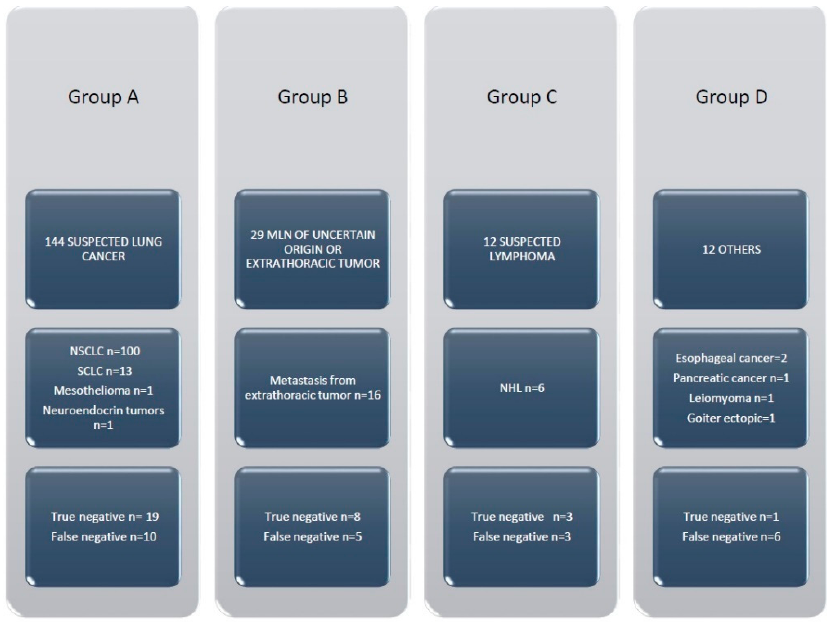
Figure 3. Final diagnoses in the four groups of patients.